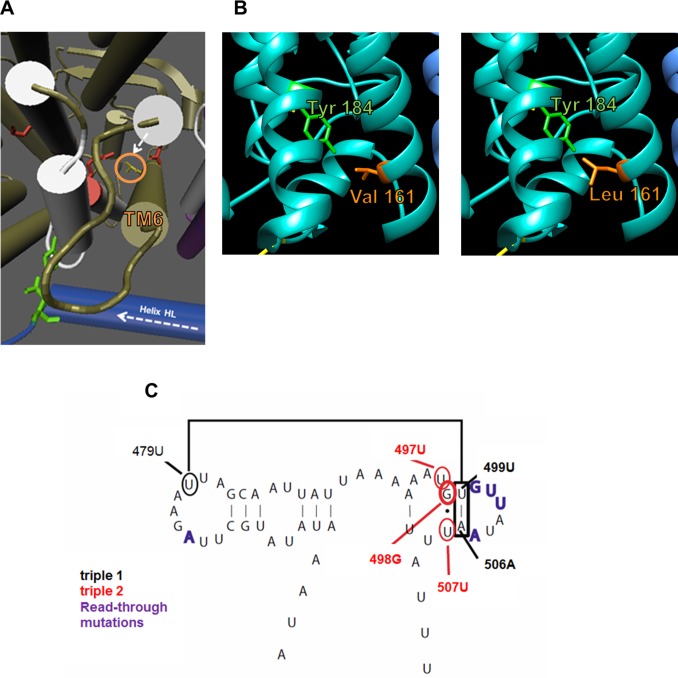
Quaternary and secondary structure modelling.(A) The V161L site on TM6 was predicted to slow the cycling of the proton pump. The shorter arrow indicates the movement of TM5 as the Helix HL moves. (B) The mutation of site 161 from valine (left panel) to leucine (right panel) likely increases steric hindrance with tyrosine 184, narrowing the proton channel. (C) The secondary structure of the GTPase center in the lrRNA of D. melanogaster showing the site of mutation and structurally related residues.